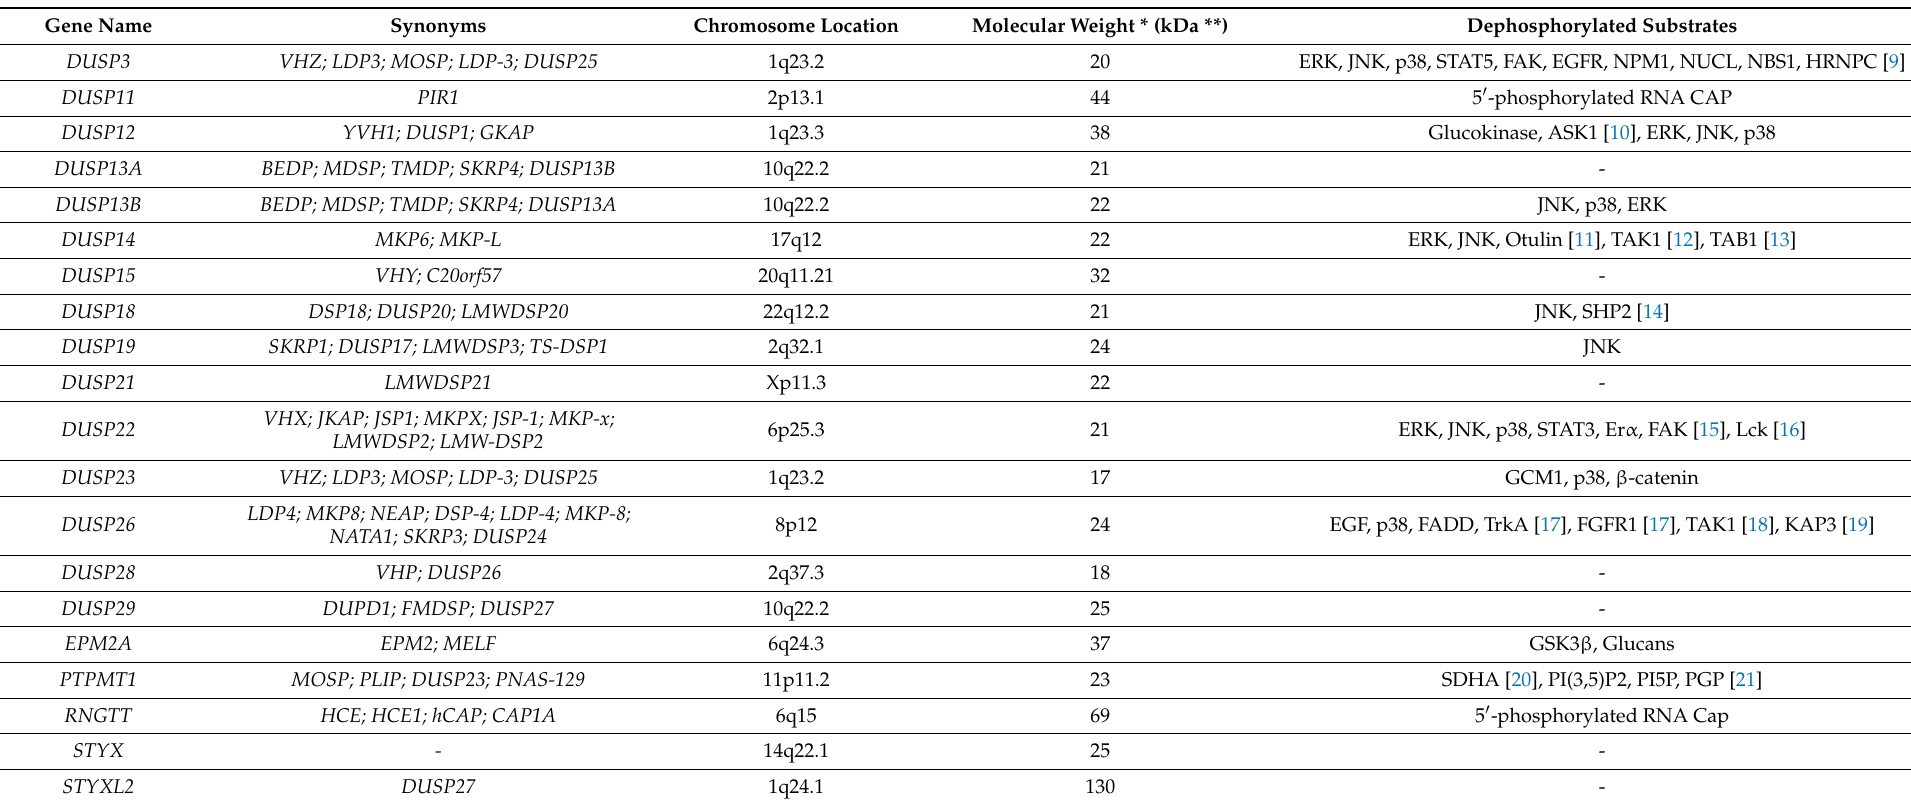
Table 1. Summary of the atypical dual specificity phosphatases (DUSPs). Adapted from [8], see additional references in the